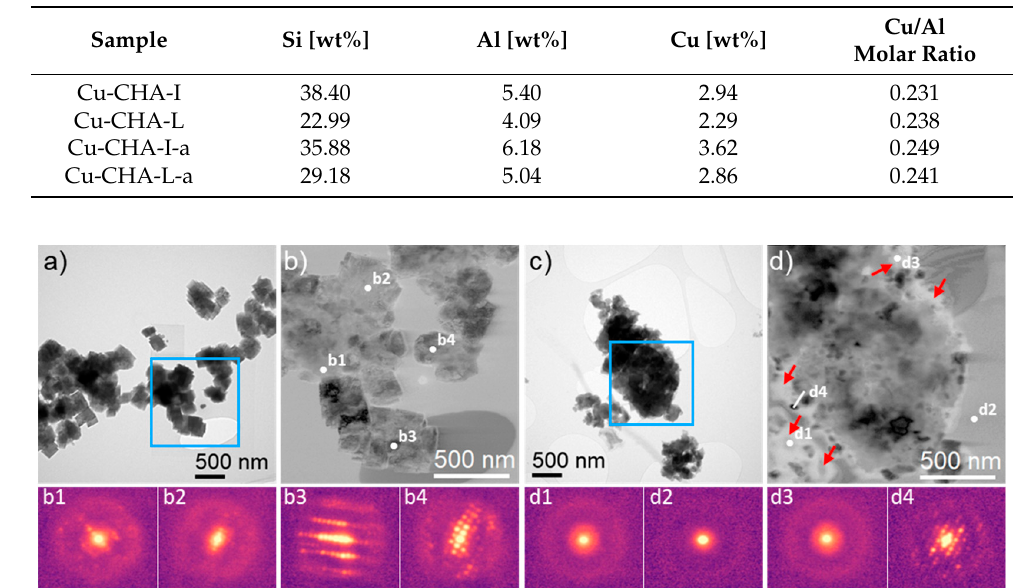
Table 1. Chemical composition determined by ICP-OES.